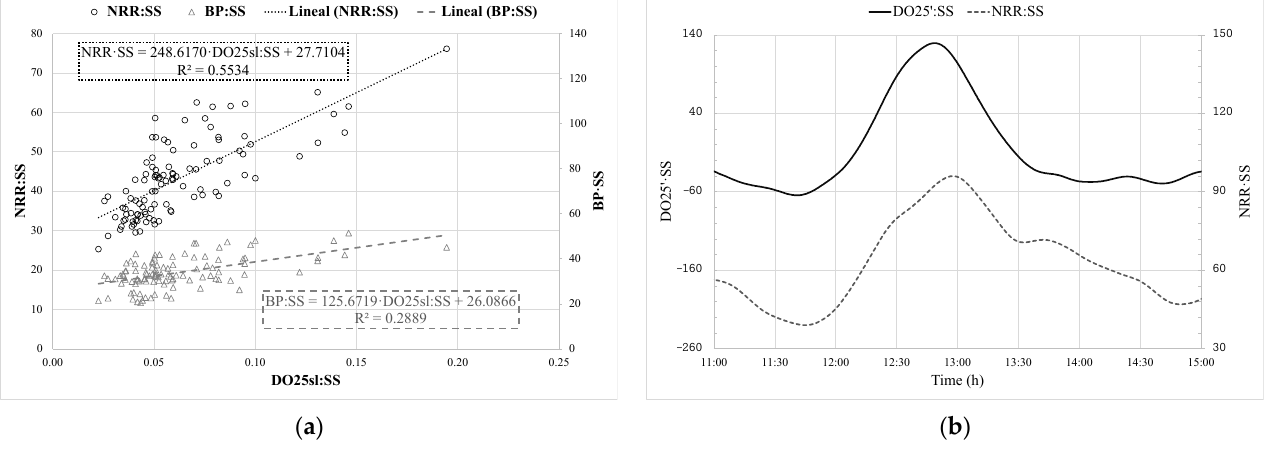
Figure 3. ( a ) Correlation between NRR:SS and BP:SS related to DO25sl:SS. All variables are calculated as daily average values. ( b ) Continuous distribution of DO25 ′ :SS and NRR:SS.